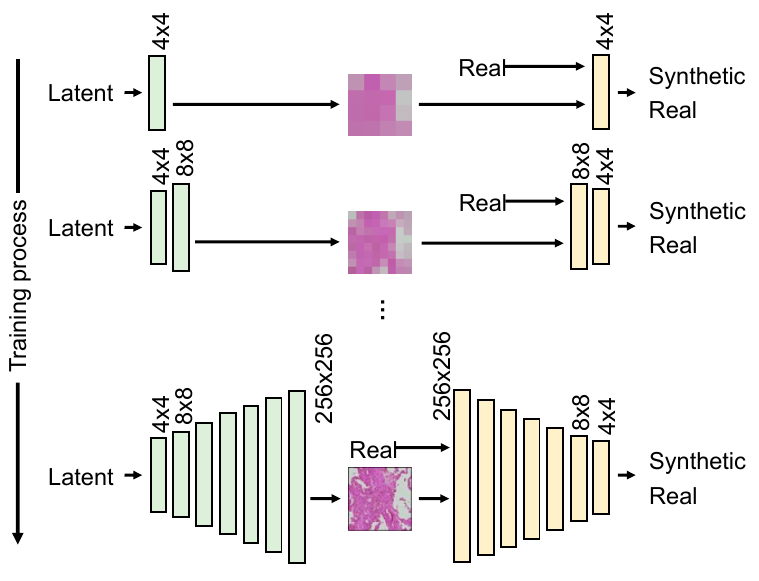
Figure 4. Architecture of PGGAN.